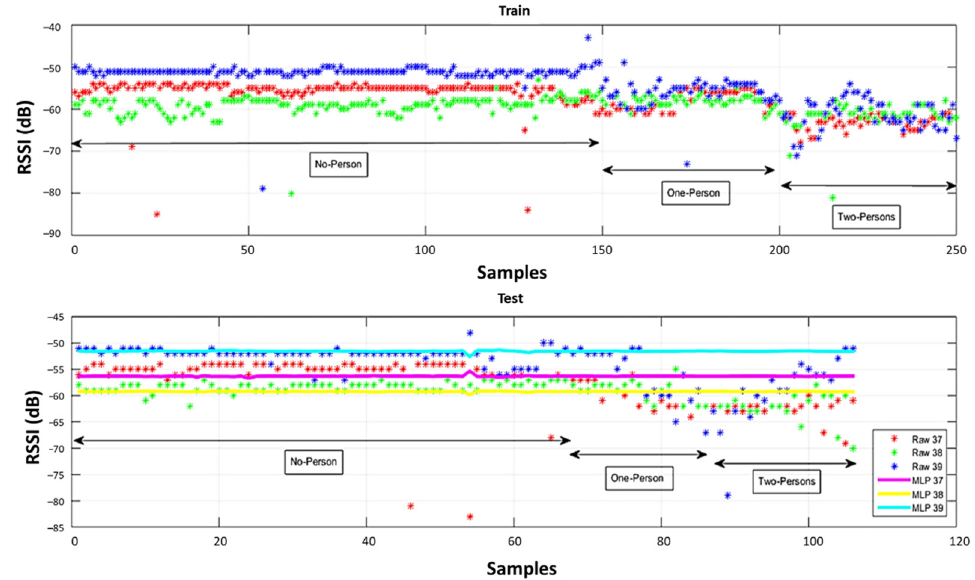
Figure 15. Comparison of the collected RSSI values before and after the ANNs testing and training.